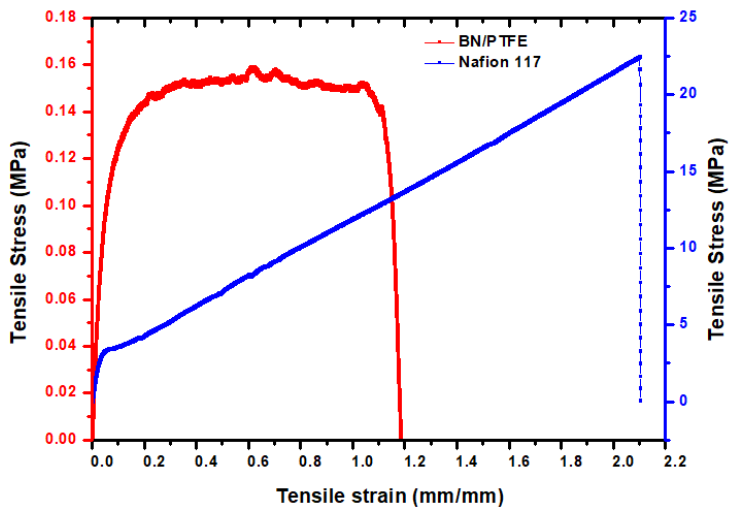
Figure 7. Representative stress–strain curve of BN/PTFE and Nafion ® 117 membranes at room tem- perature.